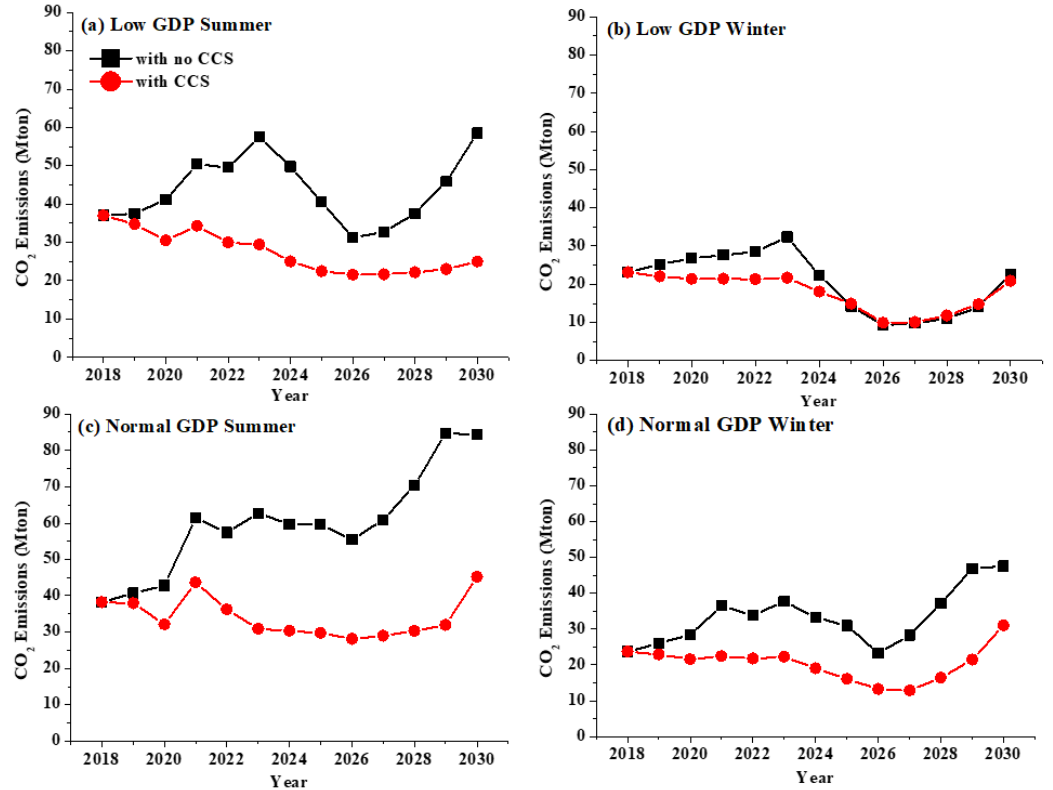
Figure 11. CO 2 emission under the carbon capture and sequestration (CCS) case (with CCS) and reference case (with no CCS).